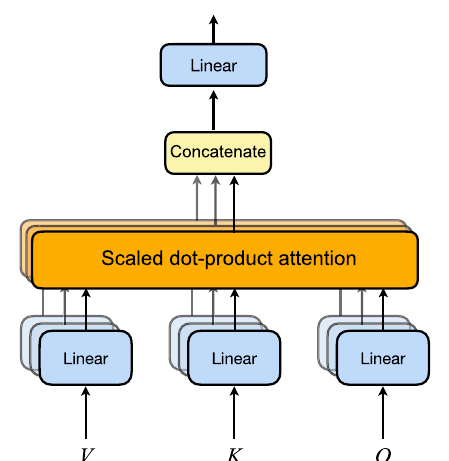
Fig. 14 Multi-head attention mechanism of Transformer. , , and denote value, key, and query in the attention mechanism,